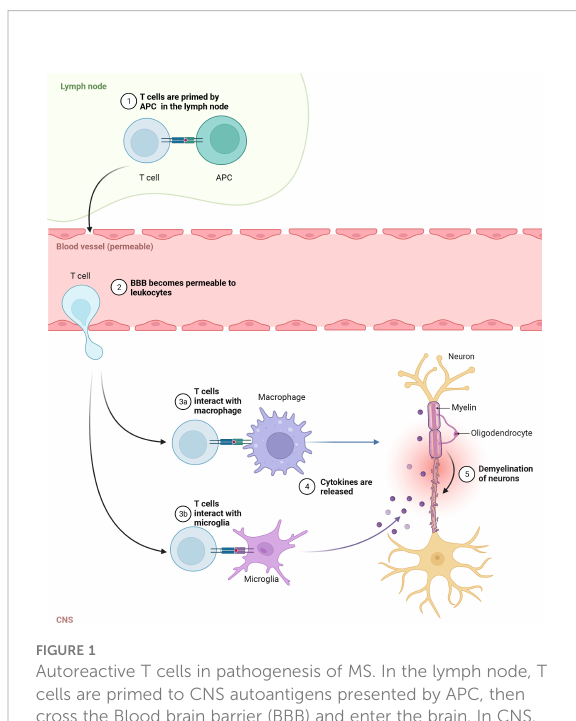
FIGURE 1 Autoreactive T cells in pathogenesis of MS. In the lymph node, T cells are primed to CNS autoantigens presented by APC, then cross the Blood brain barrier (BBB) and enter the brain. In CNS, they activate macrophages and microglia, which release cytokines promoting local in fl ammation and tissue